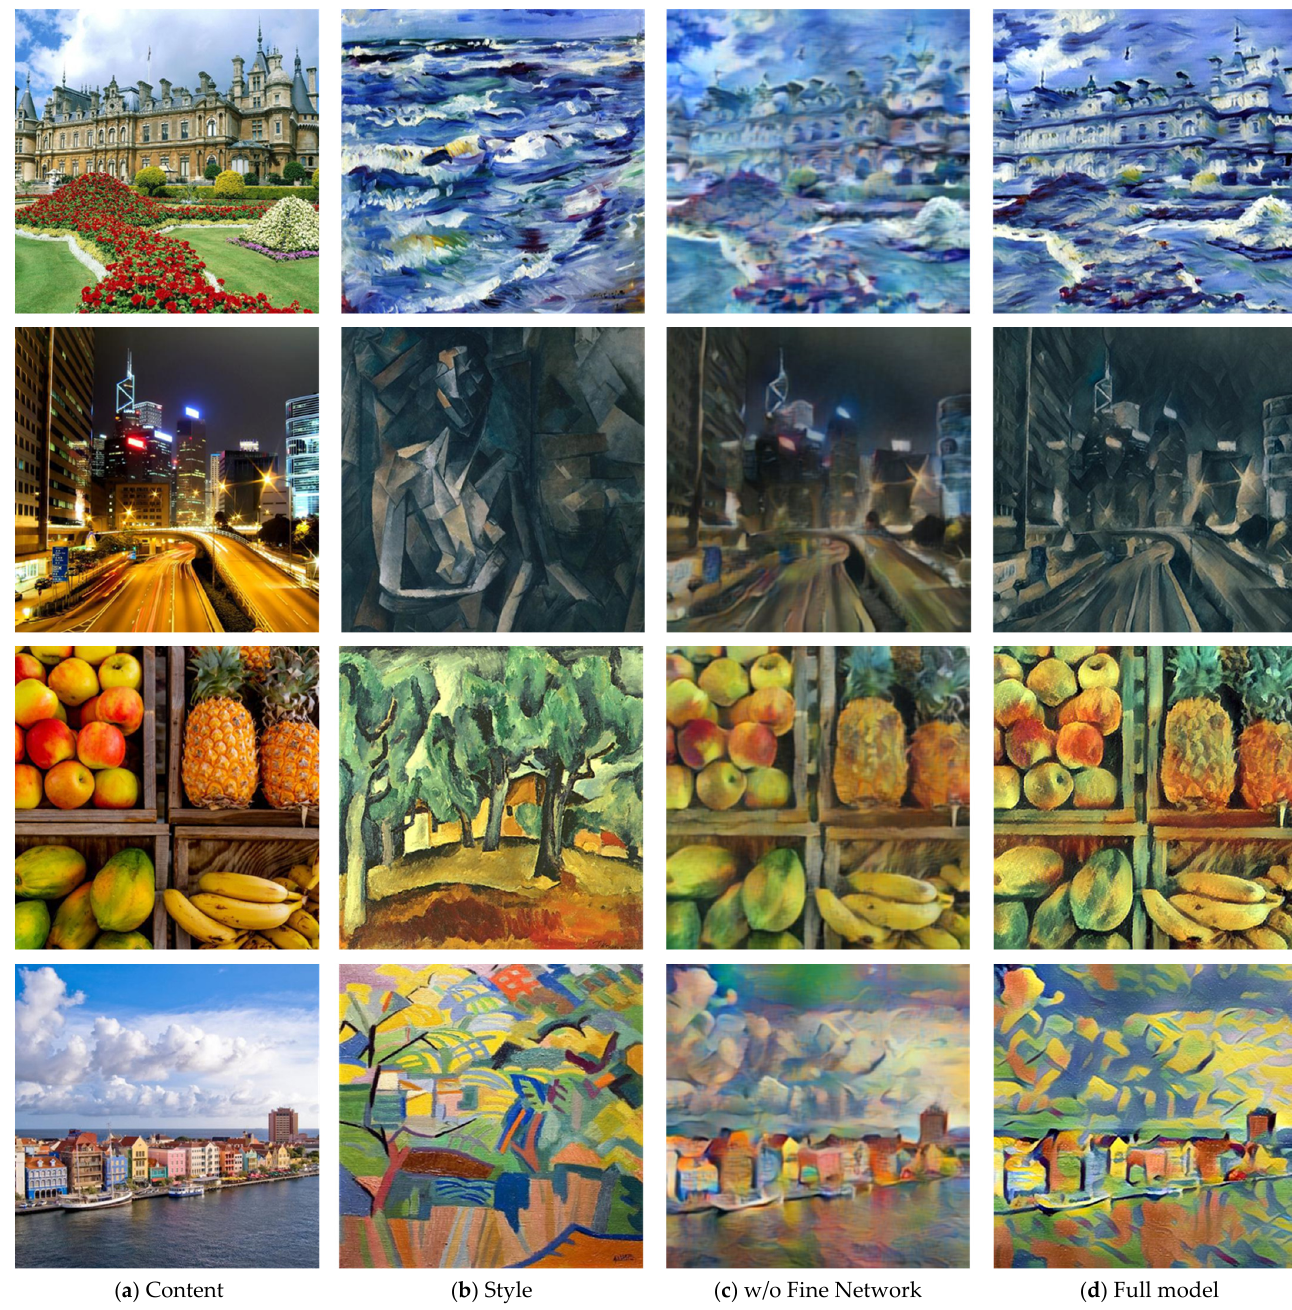
Figure 12. Comparison of stylized images of the full model and the model without the fine net- work: ( a ) the content images; ( b ) the style images; ( c ) the stylized images generated by the model without fine network; ( d ) the stylized images generated by full model.